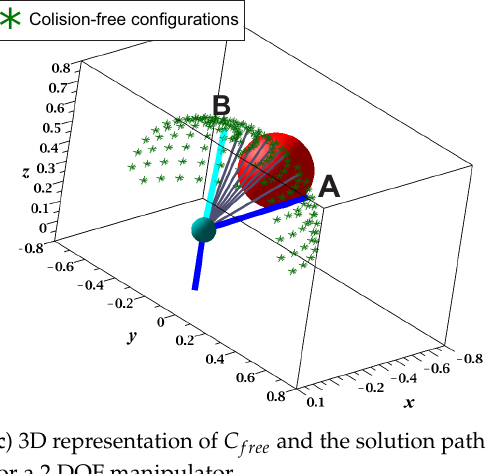
Figure 7. Configuration space ( θ 0 − θ 1 ) for a 2 DOF